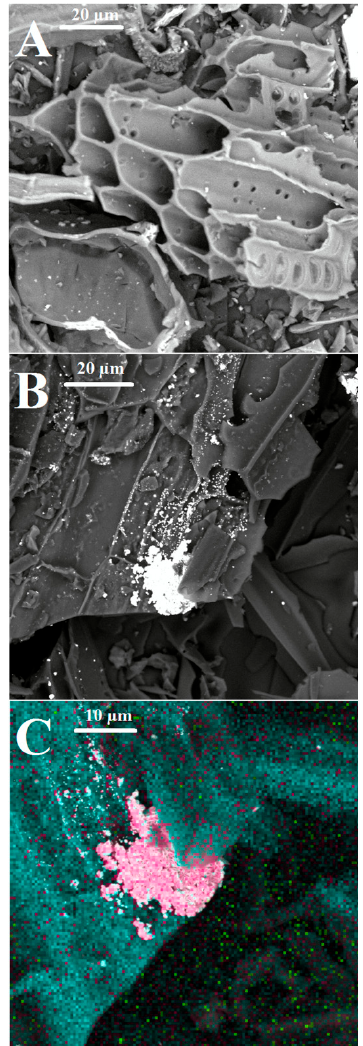
Figure 5. The SEM images of BV before ( A ) and after ( B ) adsorption (white color: Ag-NPs) and the Figure5. TheSEMimagesofBVbefore( A )andafter( B )adsorption(whitecolor: Ag-NPs)andtheresults results of EDS analysis ( C) of the selected biochar after adsorption (blue color: carbon, green color: of EDS analysis ( C ) of the selected biochar after adsorption (blue color: carbon, green color: oxygen, oxygen, pink color: silver). pink color: